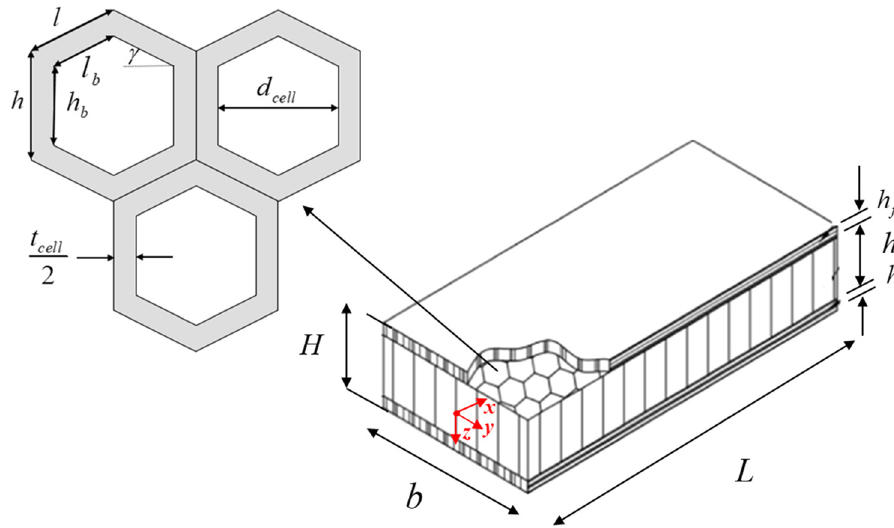
Figure 5: Schematic of a sandwich beam with honeycomb core and composite face